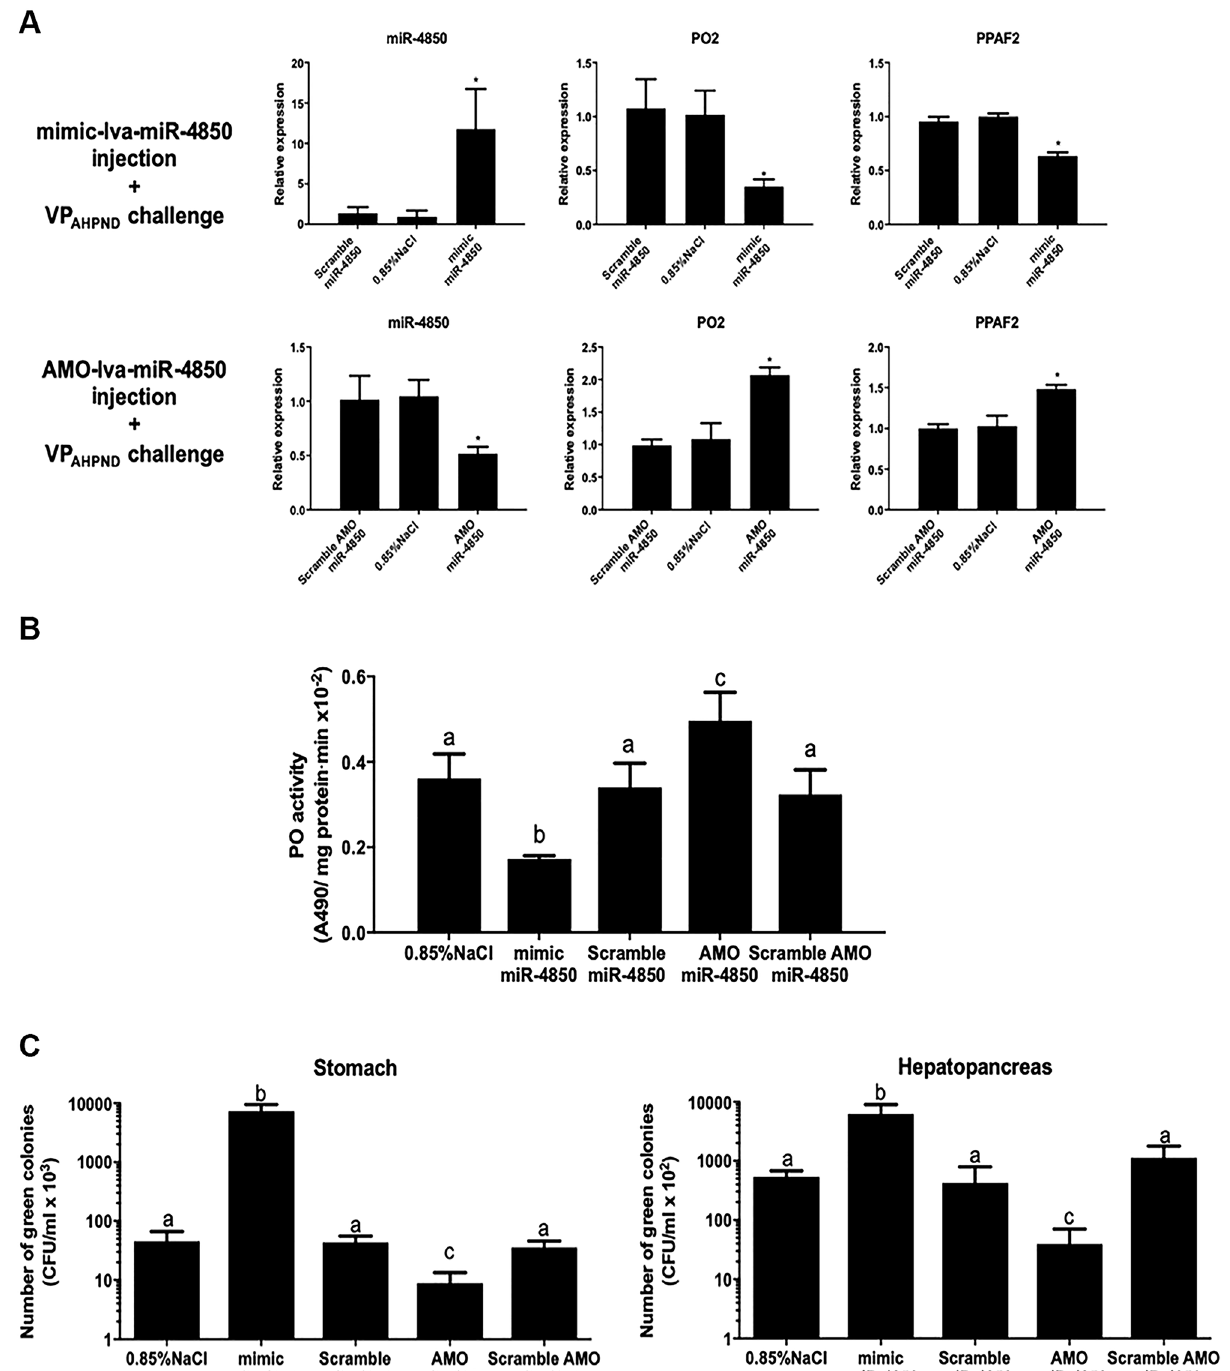
Figure 4. Regulation of PO2 and PPAF2 expression by lva-miR-4850 in VP AHPND -infected shrimp. ( A ) Expression analysis of lva-miR-4850, PO2 , and PPAF2 and ( B ) hemolymph PO activity (24 hpi) in mimic- lva-miR-4850-, scramble mimic-lva-miR-4850-, AMO-lva-miR-4850-, scramble AMO-lva-miR-4850-, or 0.85% (w/v) NaCl-injected shrimps challenged with VP AHPND . ( C ) Shrimps were injected as above, 24 h later infected with 1 × 10 6 CFU/mL VP AHPND by immersion, and then at 24 hpi the stomach and HP were harvested to determine the number of VP AHPND by dotting on TCBS agar and subsequently counting the total number of viable green colonies (CFUs). Data are shown as the mean ± 1 SD, derived from three independent repeats. Lowercase letters and asterisks indicate significant differences at P < 0.05